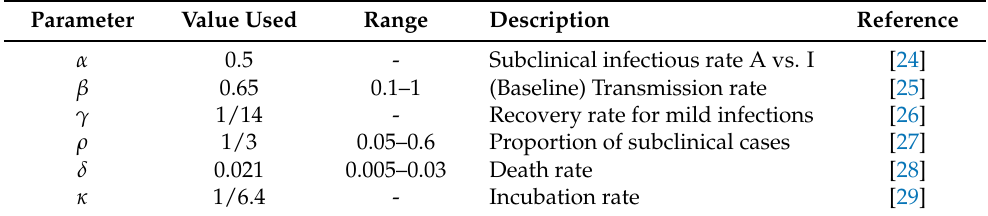
Table 1. SEAIRD epidemiological parameter